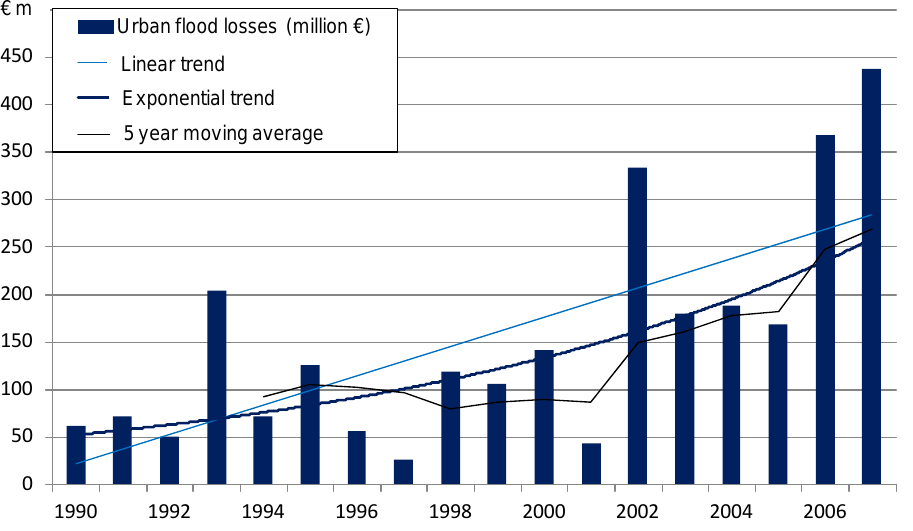
Fig. 8. Flash flood losses in Germany derived from URBAS and NatCatSERVICE databases 1990–2007 (in 2007 values) with different trend curves.